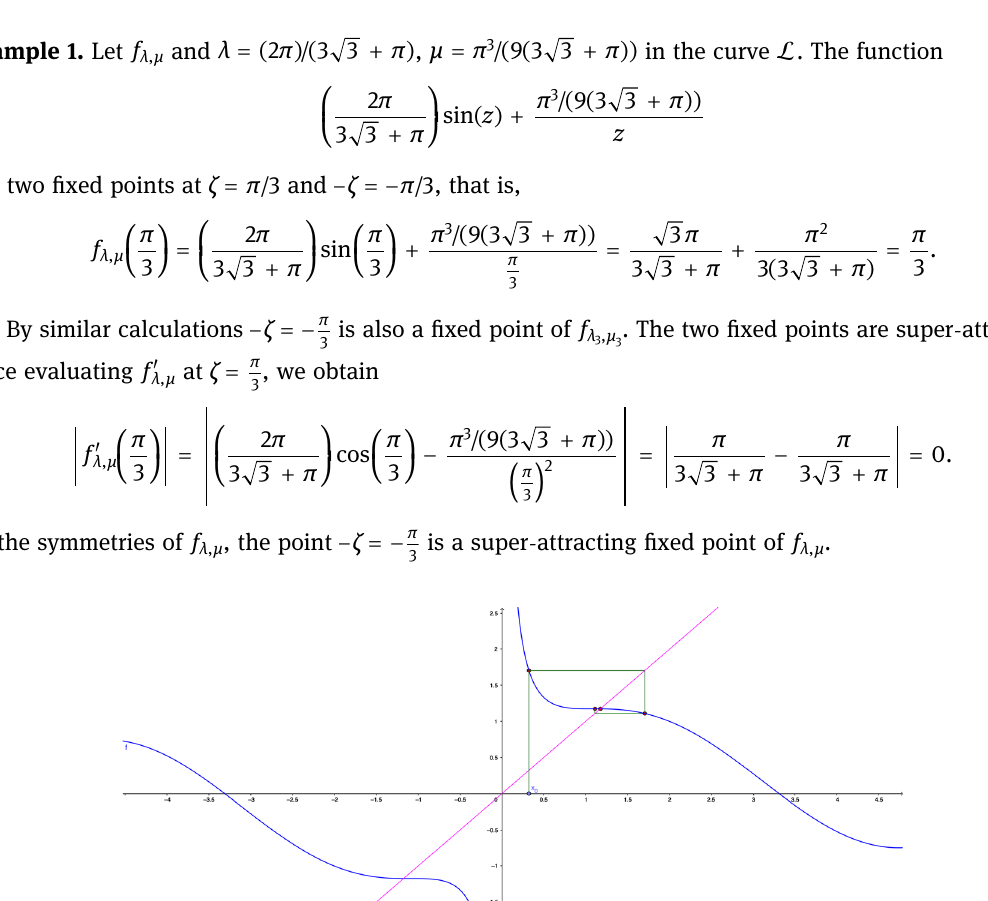
Figure 6: An orbit converging to ζ π